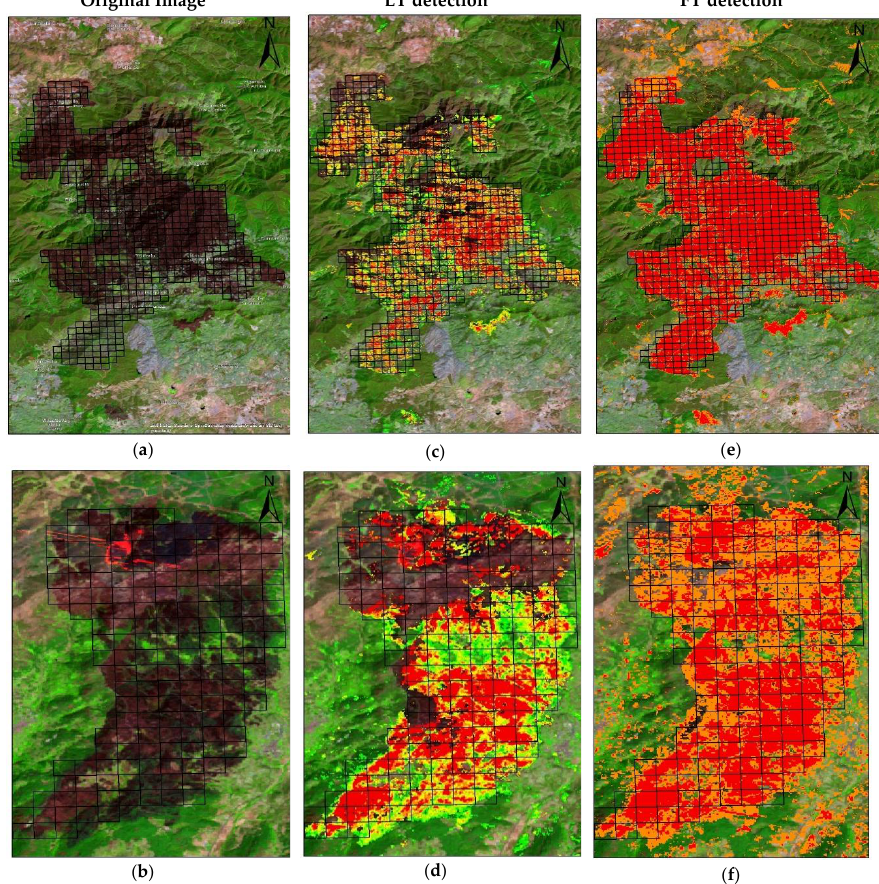
Figure 6. Performance of both algorithms (LandTrend [LT] and FormaTrend [FT]) in detecting disturbances caused by fires, compared to the burned areas detected by the MCD64A MODIS product. The left column shows two large fires in the Landsat image composition RGB 543: ( a ) fire in the year 2003 and ( b ) fire in the year 2009. The central column shows the LT detection: ( c ) in 2003 and ( d ) in 2009. Finally, the right column shows the FT detection ( e ) in 2003 and ( f ) in 2009. In red tones are the largest negative magnitudes, followed by orange, yellow, up to green tones, which indicate disturbances with low magnitudes. The visible burned grid cells are the fire areas detected by MODIS.